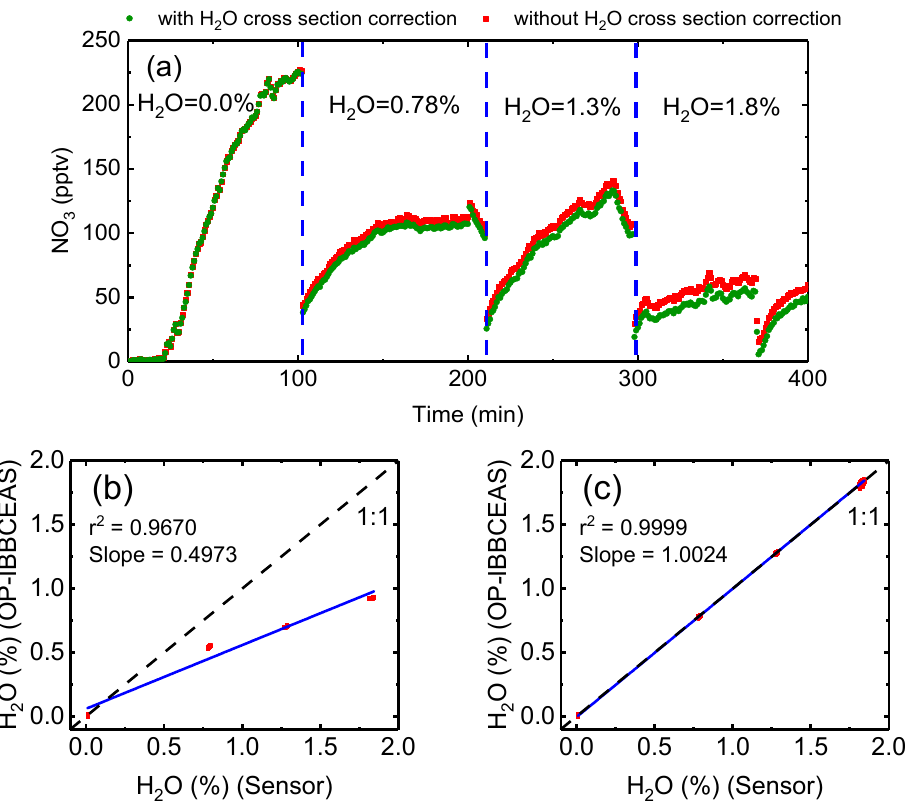
Figure 10. ( a ) NO 3 concentrations retrieved using OP-IBBCEAS with (green) and without (red) the H 2 O cross section correction. Figures ( b ) and ( c ) show the correlation of the H 2 O mixing ratio measured by a humidity sensor with that retrieved by the OP-IBBCEAS measurements. In ( b ) the uncorrected H 2 O cross section is used, whereas the corrected H 2 O cross section is used in ( c ). The H 2 O measurement precision (1 σ ) of OP-IBBCEAS is 0.02%, which is better than hu- midity sensor corresponding to 0.04% (RH = 1.7% at 22 ◦ C). The correlation and